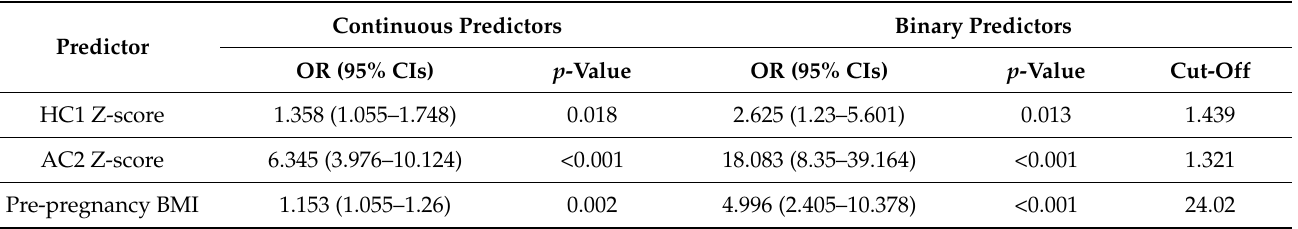
Table 3. Results of multivariable logistic regression model to predict LGA using dichotomous predictors using type (LGA vs. AGA).